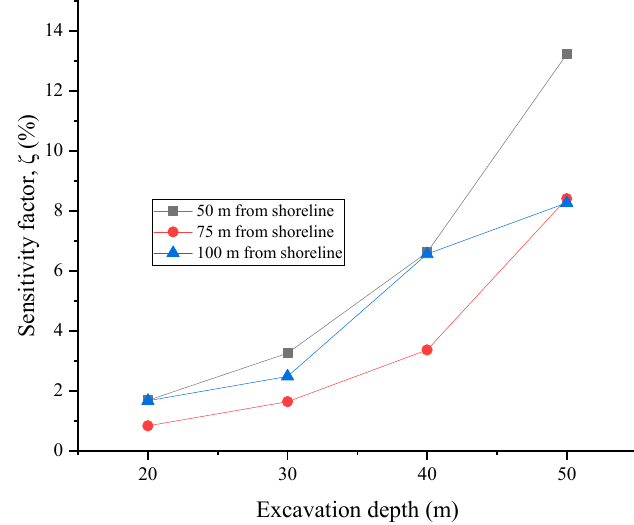
Figure 17. Sensitivity factor vs. excavation depth.